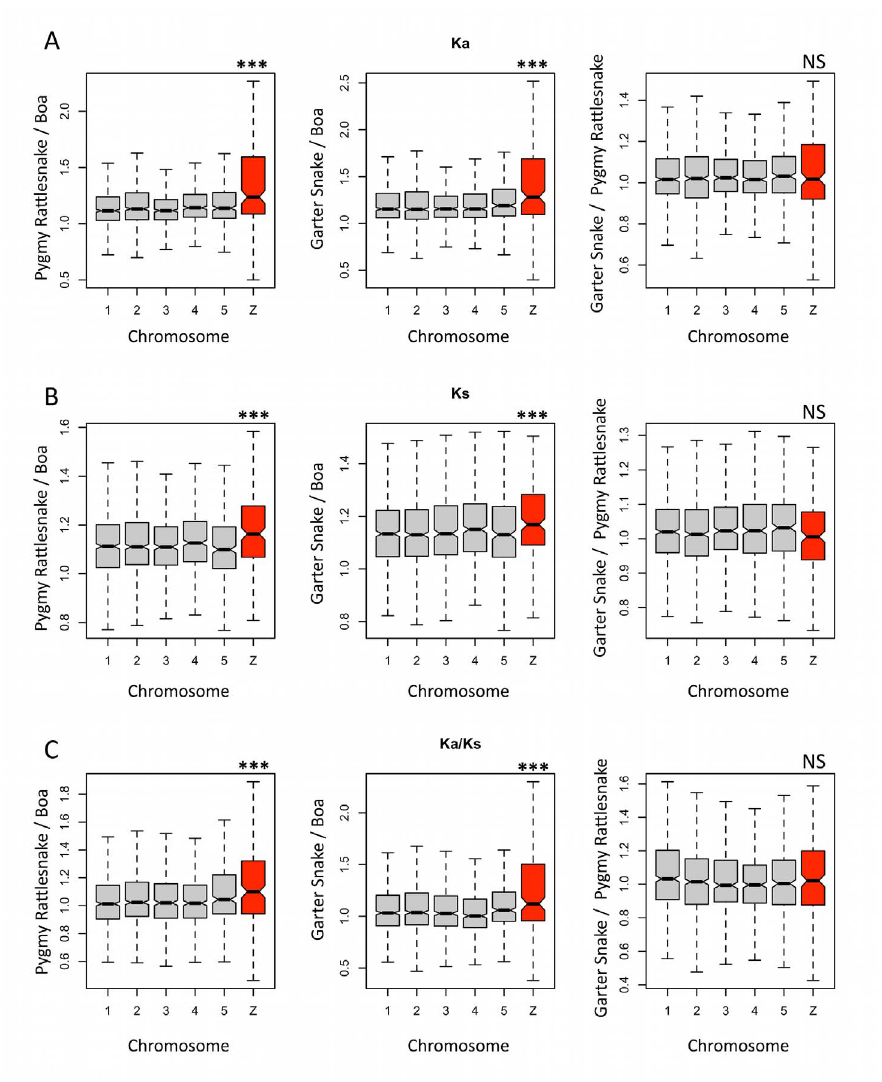
Figure 4. Molecular evolution of snake Z chromosomes and autosomes at synonymous sites (K s ) and non-synonymous sites (K a ), and their ratio (K a /K s ). For each gene, we calculated the Anolis -boa, Anolis -pygmy rattlesnake, and Anolis -garter snake rates of synonymous and non-synonymous evolution. To detect branch-specific differences, we obtained for each gene the ratios of these evolutionary rates between the different snake species pairs (pygmy rattlesnake/boa, garter snake/boa, and garter snake/pygmy rattlesnake), and plotted them for each macrochromosome. Please note that in the figure, ‘‘Pygmy Rattlesnake/Boa’’ refers to the ratio: pygmy- Anolis divergence/boa- Anolis divergence, and so on. Significant differences between the Z-chromosome and the autosomes are marked with asterisks (***, p , 0.001; NS, non-significant).